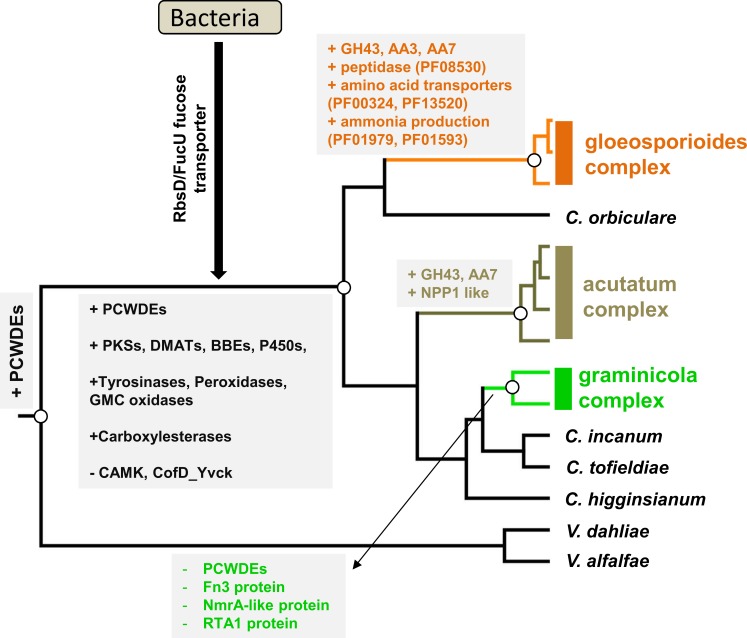
A summary representation of the important evolutionary events of Colletotrichum gene families.